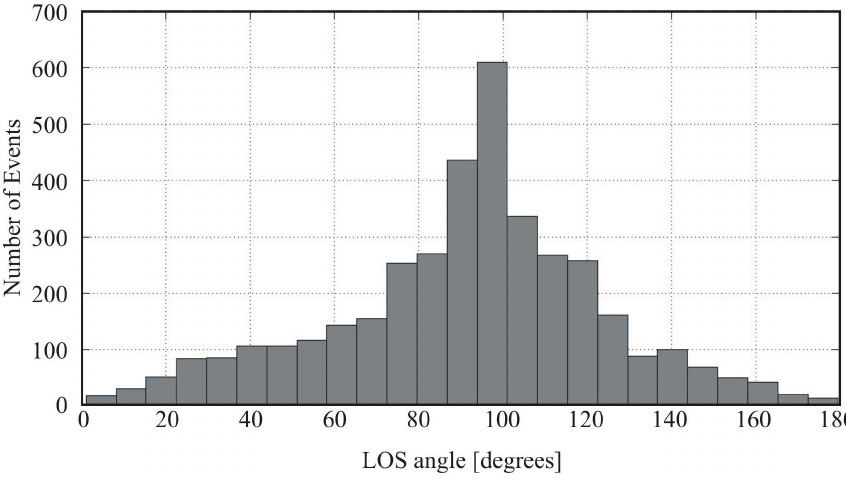
Fig. 6. LOS angle distribution for all the studied cases.